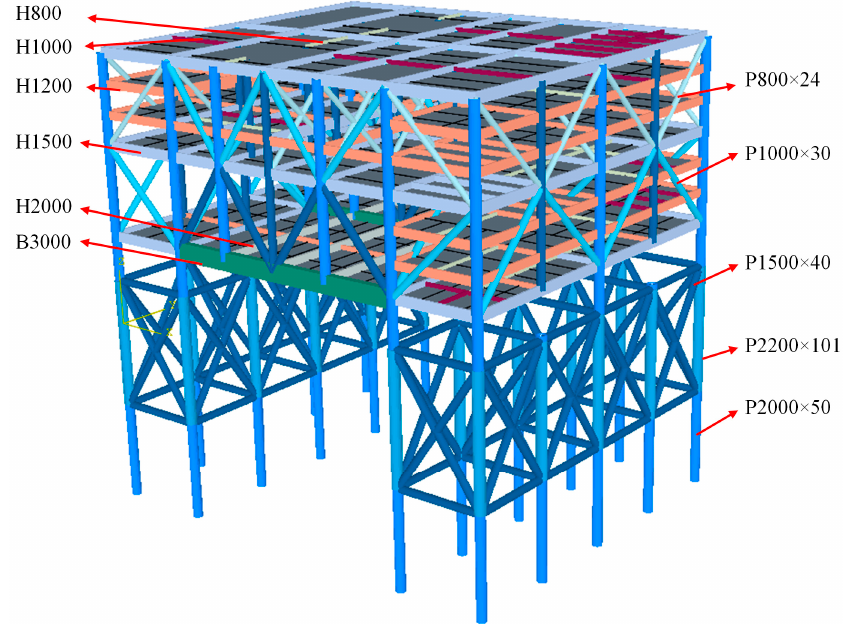
Figure 1. Schematic diagram of the electrical platform. Table 2. Geometric dimension parameters of the superstructure model.